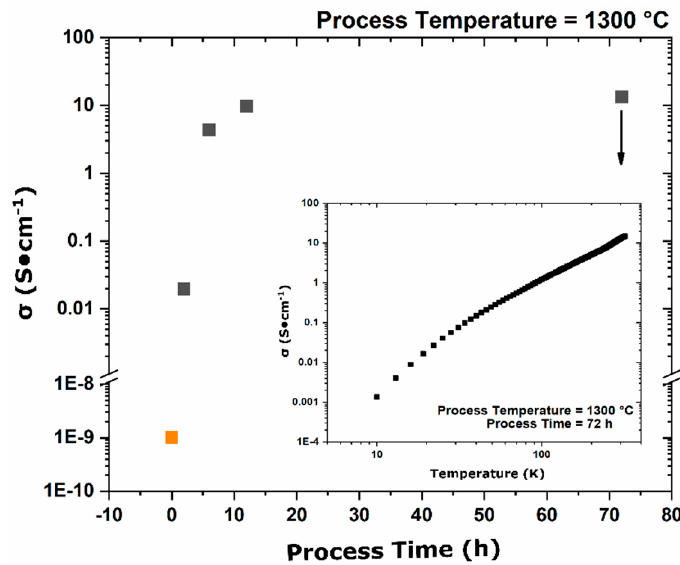
Figure 9. Electrical conductivity of oxy-C12A7 samples processed at 1300 ◦ C for various durations. Figure 9 . Electrical conductivity of oxy-C12A7 samples processed at 1300 °C for various durations. The conductivity converged to a value of 15 S · cm − 1 . The inset shows the temperature dependence of The conductivity converged to a value of 15 S·cm -1 . The inset shows the temperature dependence of the sample, which was reduced for 72 h, indicating the sample was the sample, which was reduced for 72 h, indicating the sample was semi-conducting.